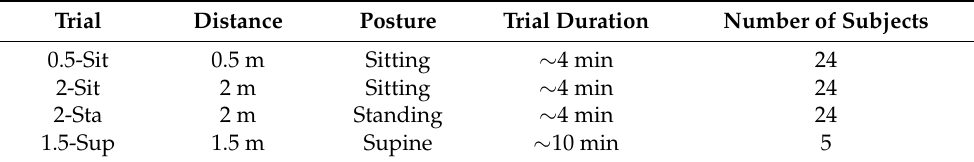
Table 1. Experimental Protocol: distances, postures, durations, and enrolled volunteers in each trial. Trial Distance Posture Trial Duration Number of Subjects